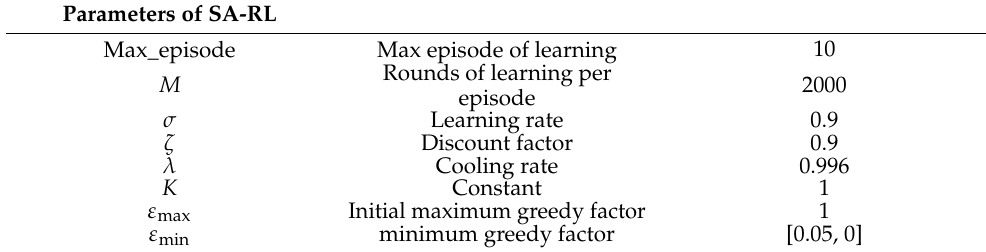
Table 2. Simulation parameters of